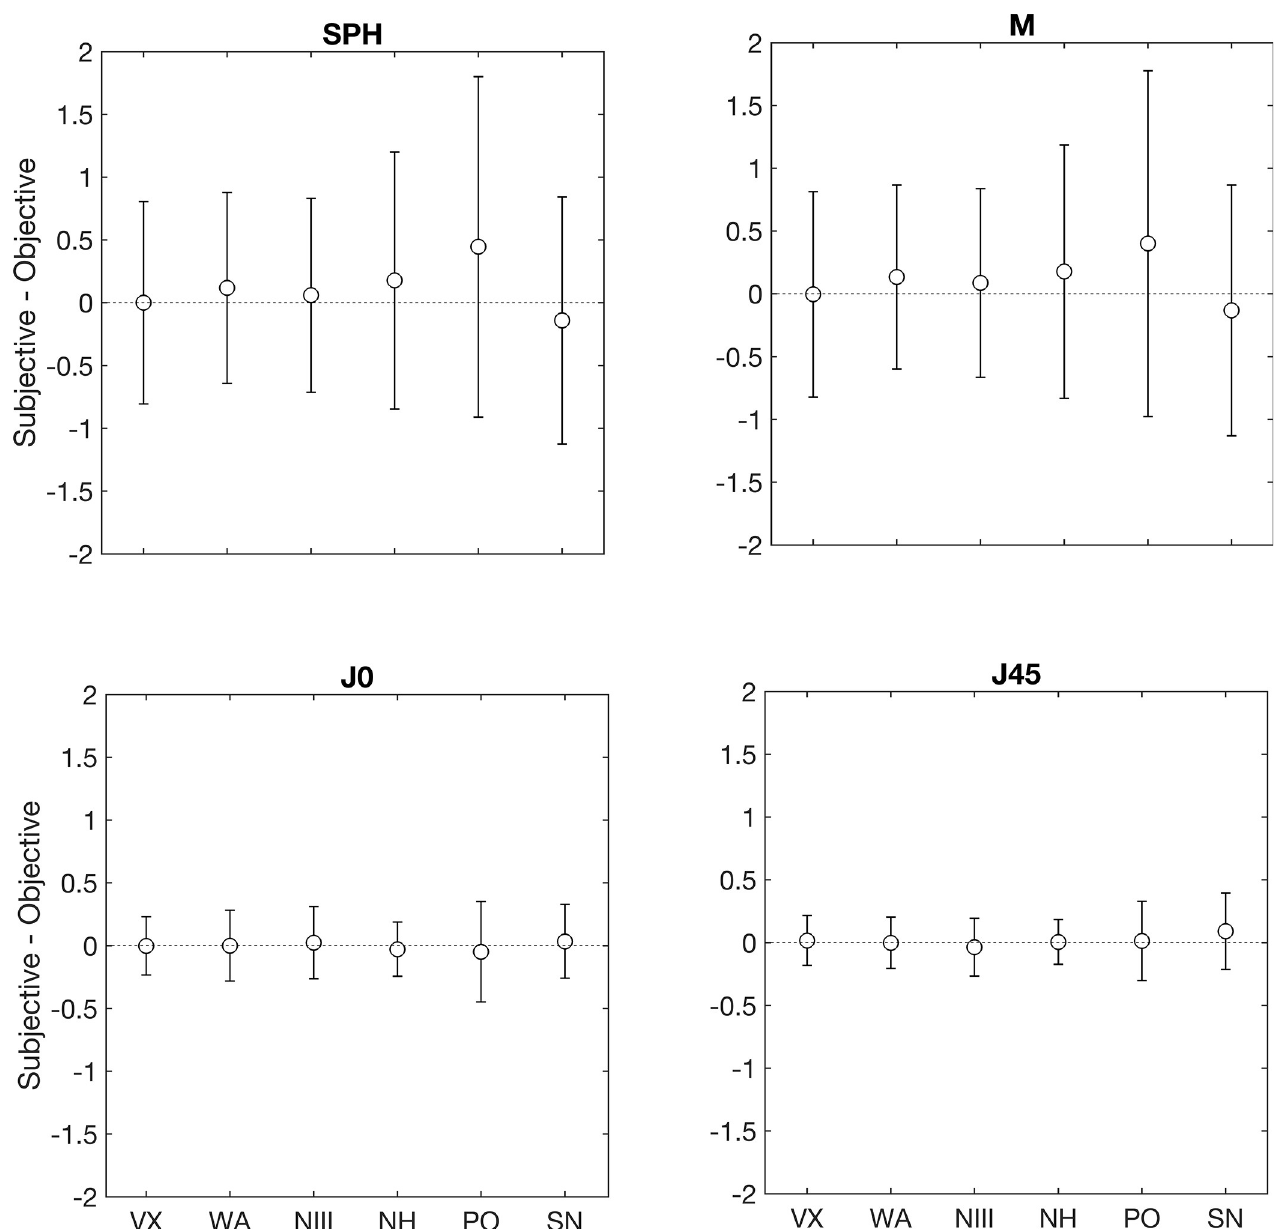
Fig 3. Bland-Altman plots for sphere, spherical equivalent and the cylindrical vector components. The open circle represents the mean difference between the subjective refraction and each autorefractor, and the error bars denote the 95% limits of agreement. Check Fig 1 captions for abbreviations.